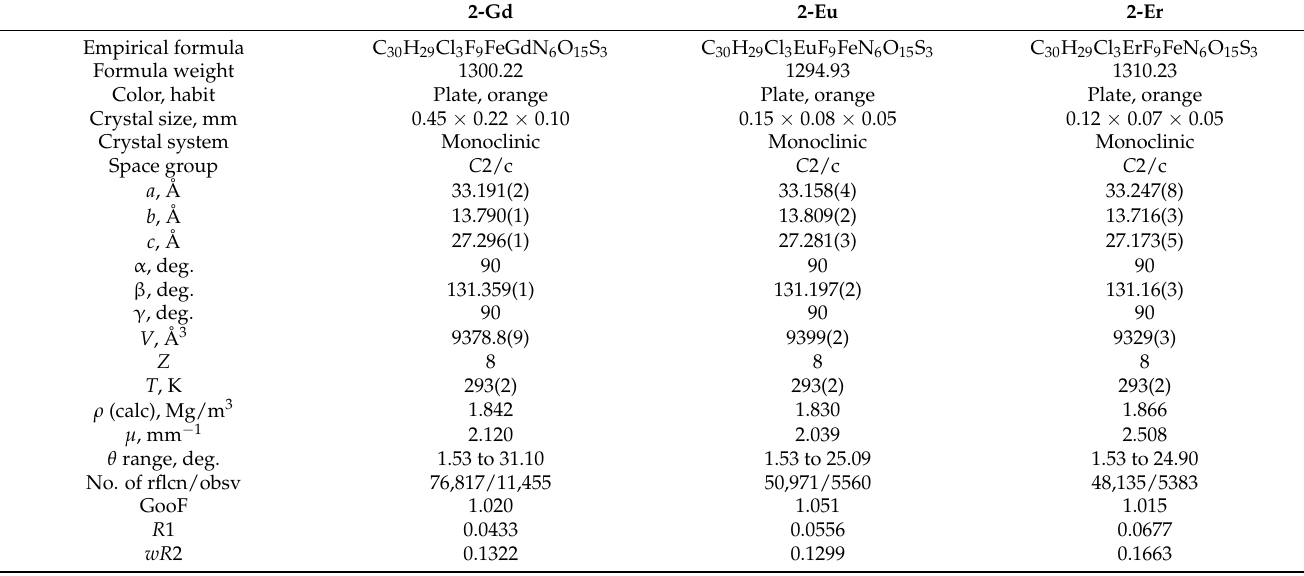
Table 2. Summary of X-ray crystallographic data for 2 -Ln.